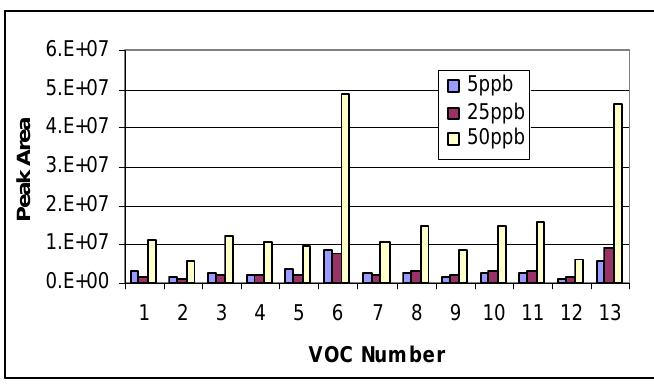
FIGURE 5 . Uncorrected VOC peak areas comparison at three-level